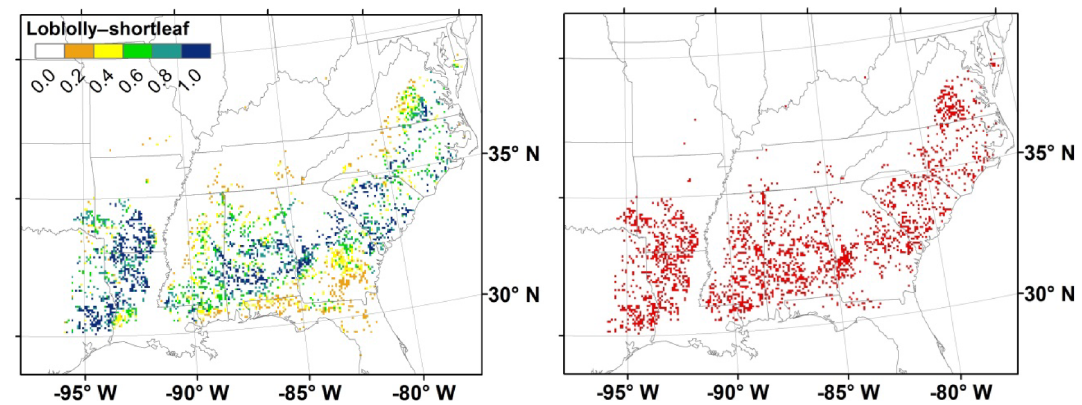
Figure 6. Illustration of the generation of spatial distribution maps for tree species groups in terms of fractional data and regional inventory area data using loblolly–shortleaf pine as an example. Left panel: fraction of loblolly–shortleaf pine species group in each grid cell; right: identified final grid cells with loblolly–shortleaf